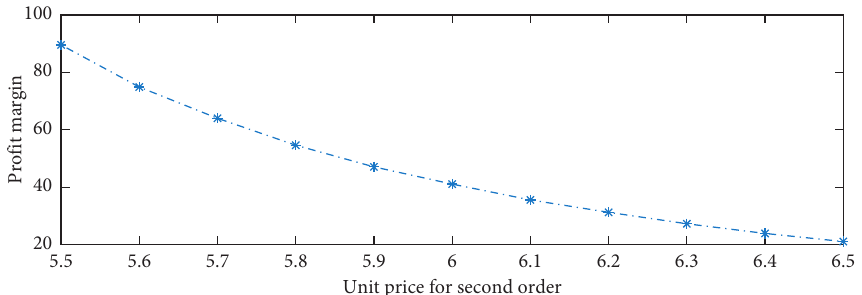
Figure 5: Profit difference between quick response mechanism and single order